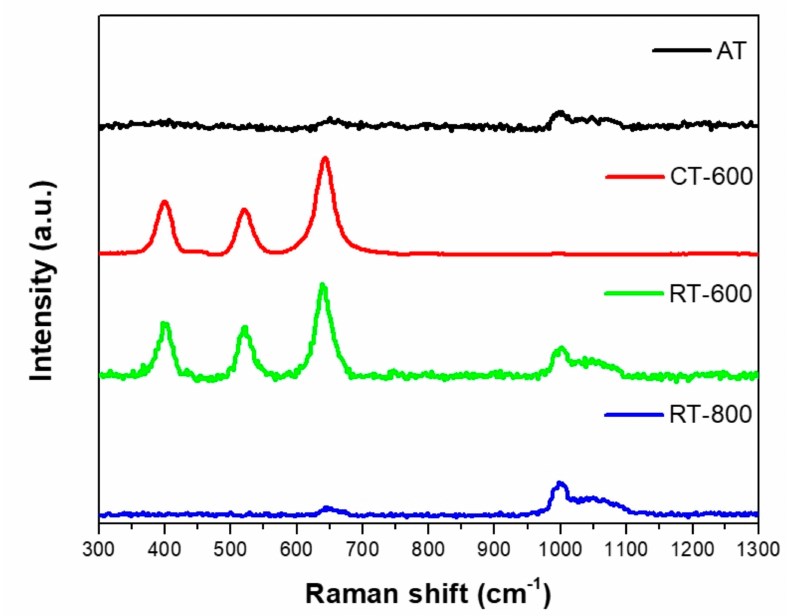
Figure 4. Raman spectra of amorphous TiO 2 (AT), CT-600, RT-600, and